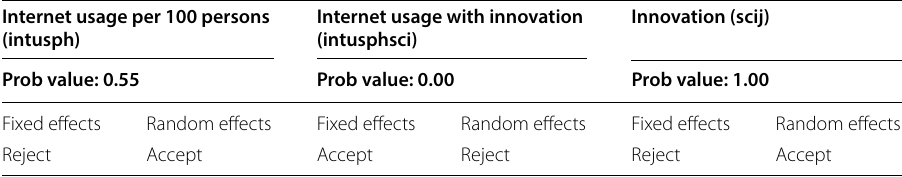
Table 4 Hausman test result. Source : computed by the authors Internet usage per 100 persons (intusph)